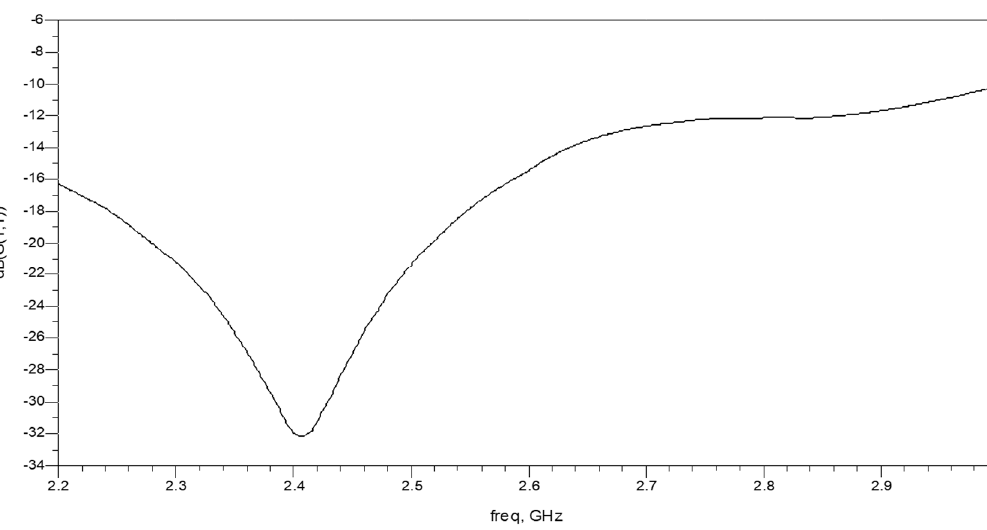
Figure 12. S11 of Transmitting Circular Patch antenna.